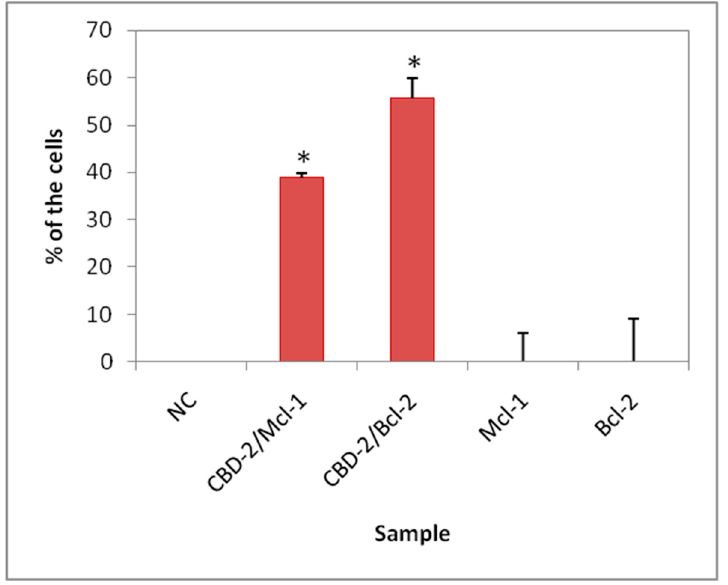
Figure 9. Percentage of cells containing dendrimer/siRNA complexes after 24-hour exposure to dendriplexes or naked siRNA; NC, untreated cells. The dendrimer/siRNA charge ratio was 20:1, and the concentration of dendrimer was 2 μ M; * p < 0.05.